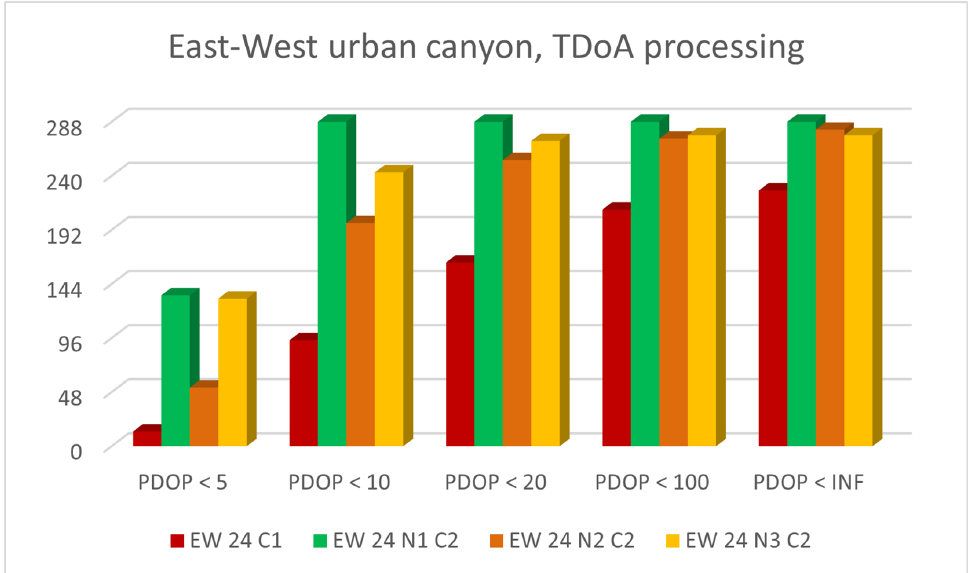
Figure 11. Number of epochs with PDOP values smaller than 5, 10, 20, 100 or ∞ for east-west urban canyon with CG, N5-CG-TDoA, N4-CG-TDoA and N3-CG-ToA signal configurations.